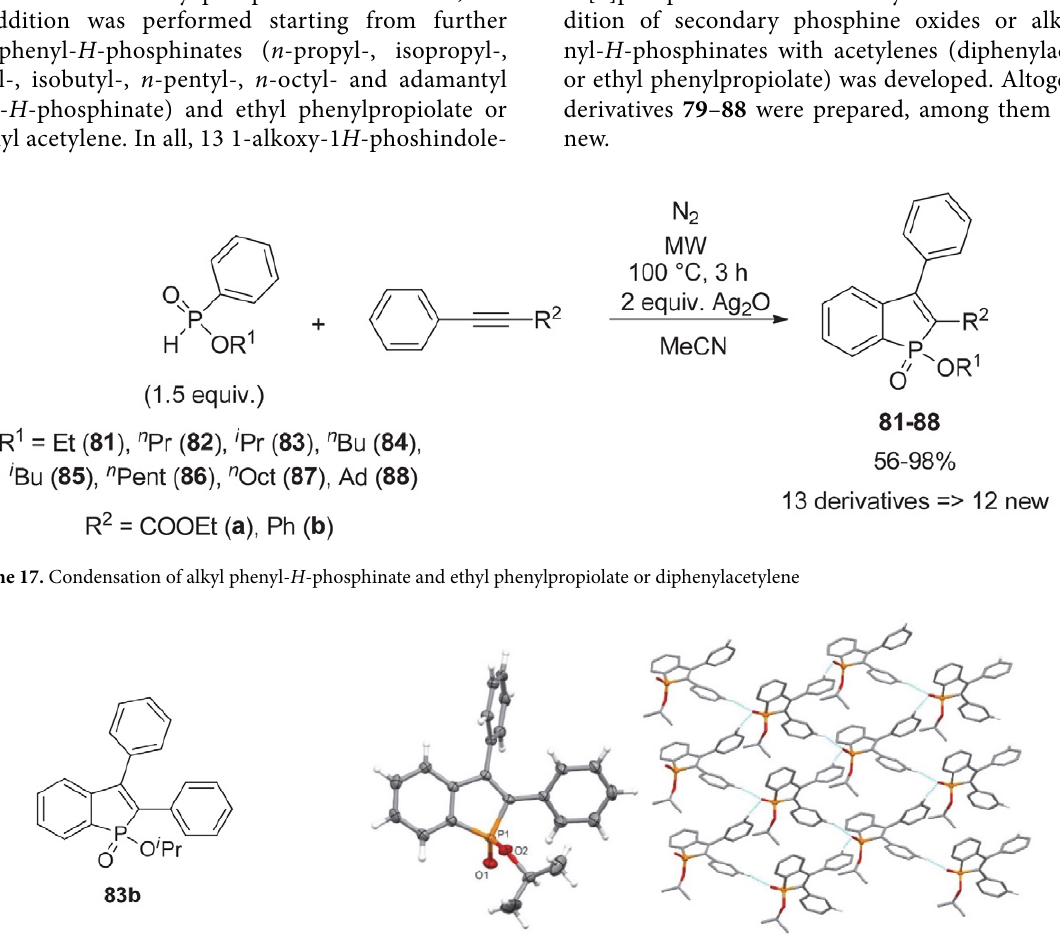
Figure 8. The crystal structure of 1-isopropoxy-2,3-diphenylphosphindole 1-oxide ( 83b